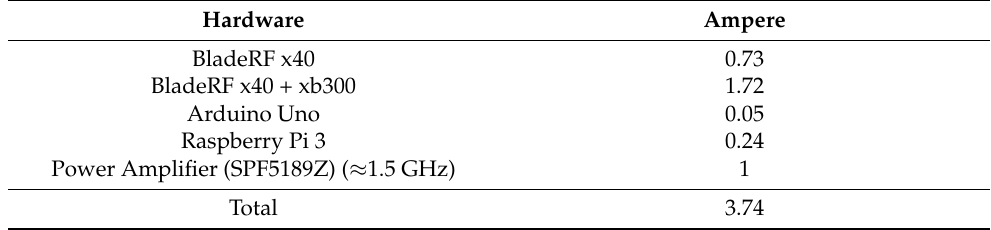
Table 2. Hardware current